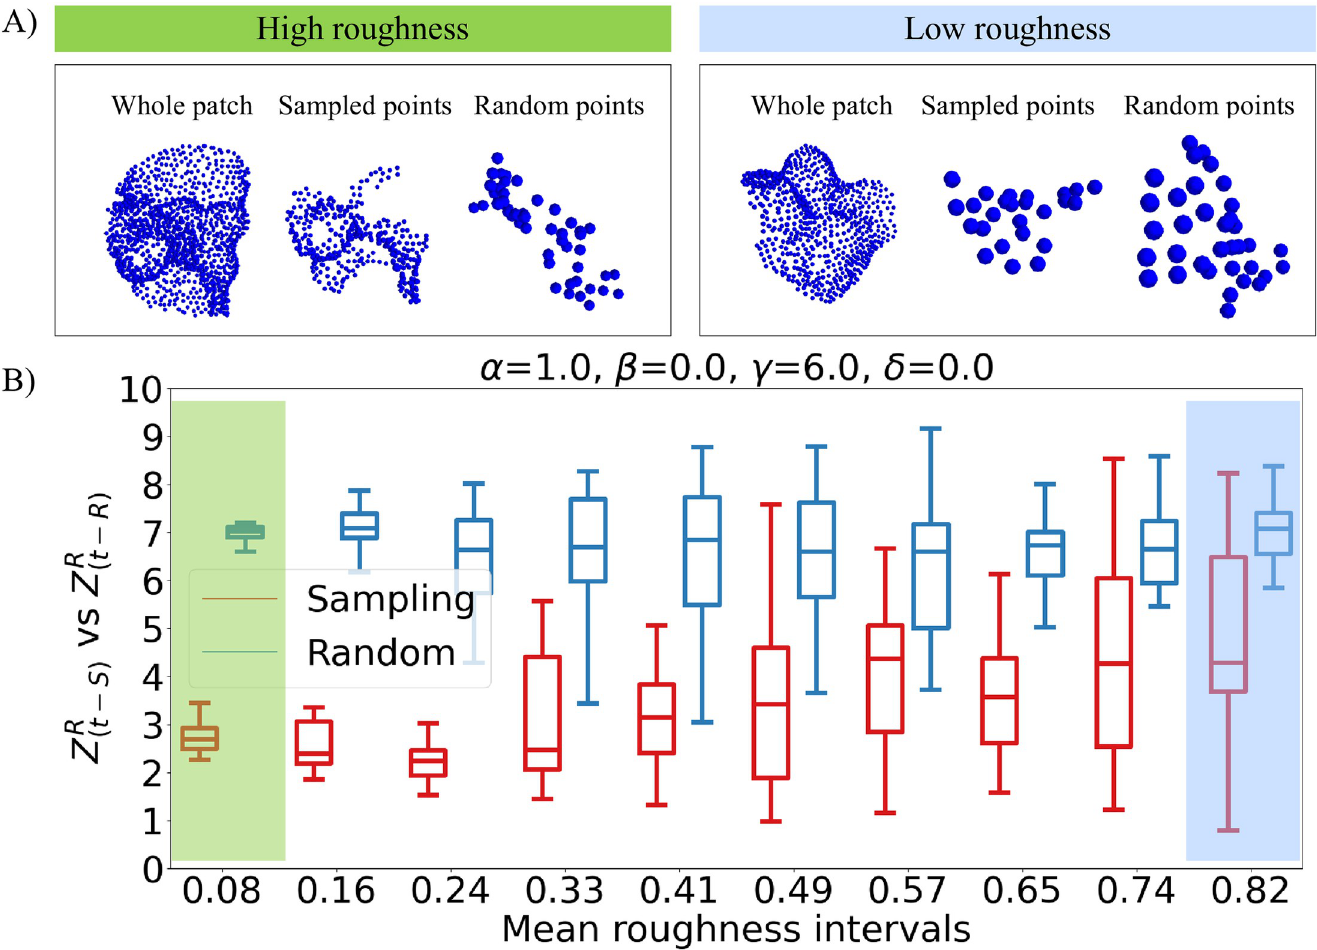
Fig 5. Comparison between the best sampling and the random selection of points for patches with different roughness. A) On the left, an example of how a rough patch is represented with all the points in the surface ( whole patch ), with only the points resulting from the sampling ( sampled points ) and with randomly extracted points ( random points ). On the right, the same three representation cases for a plane patch. B) In red, the box plot for different ranges of patches’ roughness of Z R . This is in the case of a sampling with parameters α = 1, β = 0, γ = 6 and δ = 0, whose combination blue, the box plot for different ranges of patches’ roughness of Z R t (cid:0) R results in the highest value of d for the A1